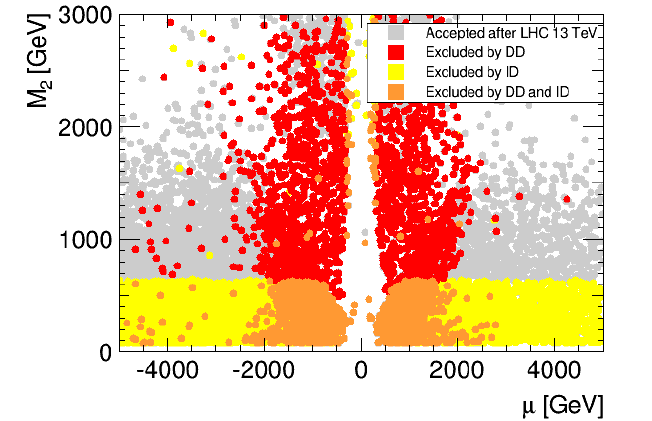
Figure 17 . pMSSM points in the ( (cid:22); M 2 ) parameter plane. The accepted parameter points which are in agreement with the LHC 8 and 13 TeV data from Higgs and direct searches are shown in gray. The red points are in addition excluded by direct detection, the yellow points by indirect detection and the orange points by direct and indirect detections